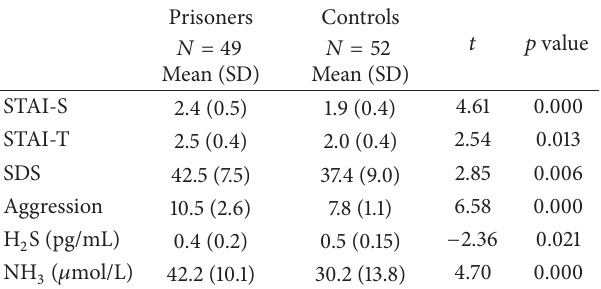
Table 2: Independent 𝑡 -test for psychological and biological test